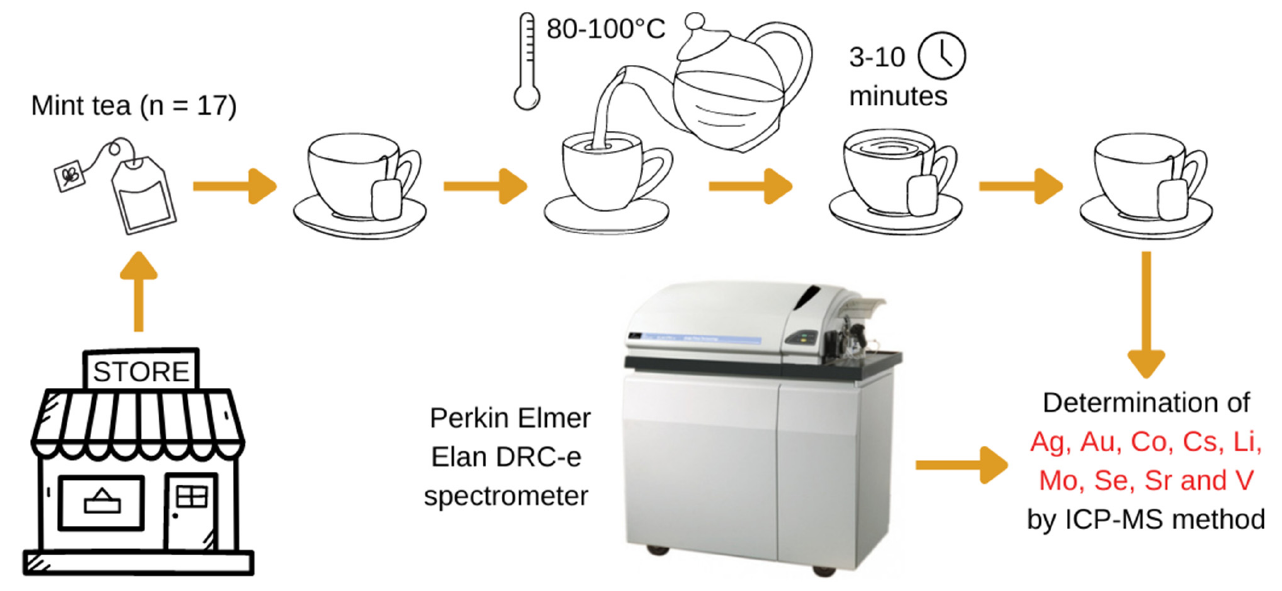
Figure 1. The mint tea infusions process procedure workflow and the determination of investigated elements: Ag, Au, Co, Cs, Li, Mo, Se, Sr, and V.